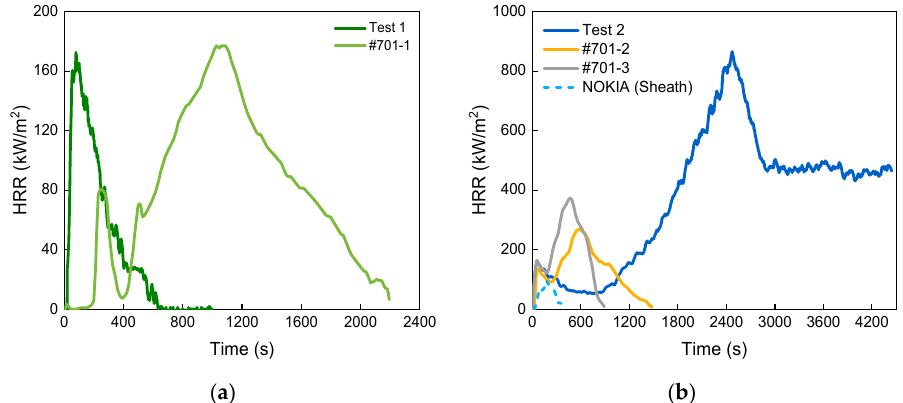
Figure 8. Heat release rates for Cable ZRC-YJV-8.7/10 3 × 95 mm 2 in: ( a ) Test 1; ( b ) Test 2 in comparison with other cable tests.